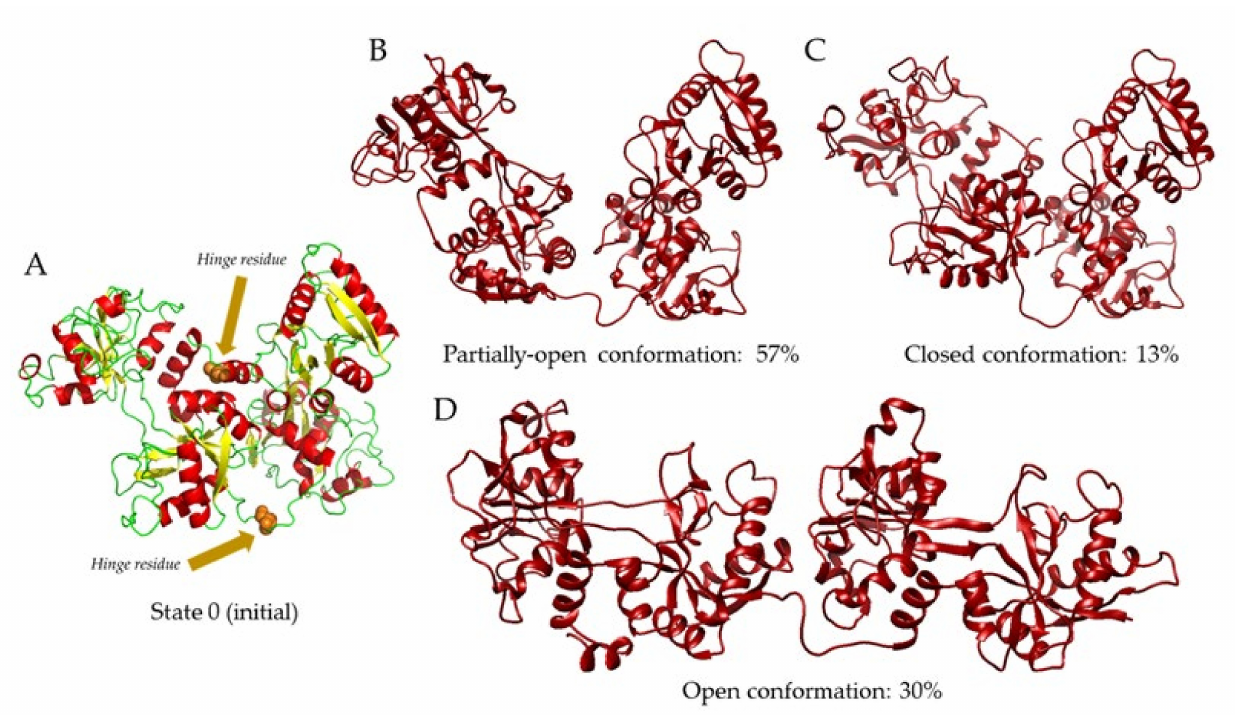
Figure 3. SAXS-based pseudo-atomic modeling using MultiFoXS for holo-Tf at pH 5.5. Multi-state models at different pH values were obtained after sampling over 10,000 conformations using the 2HAV (chain A) structure as a starting model and Thr371 and Leu671 as hinge residues (shown by spheres), corresponding to State 0 ( A ). For State 3, three conformations were observed in the following proportions: partially open, 57% ( B ); closed, 13% ( C ); open, 30% ( D